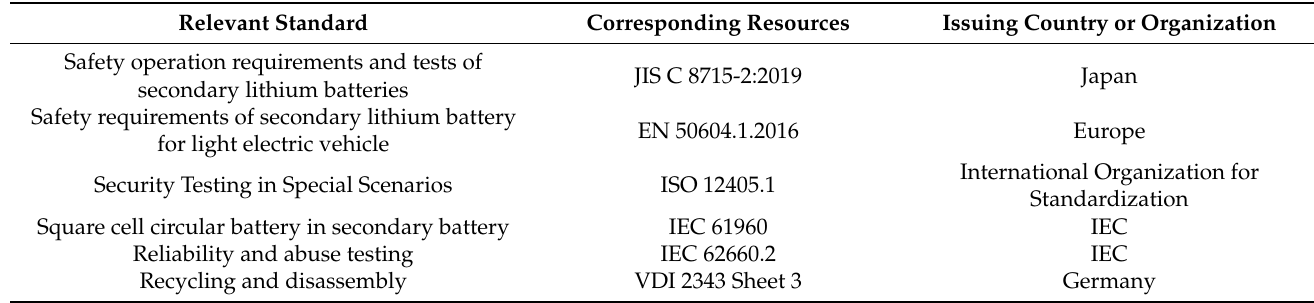
Table 3. International standards for related echelon utilization and disassembly recycling.